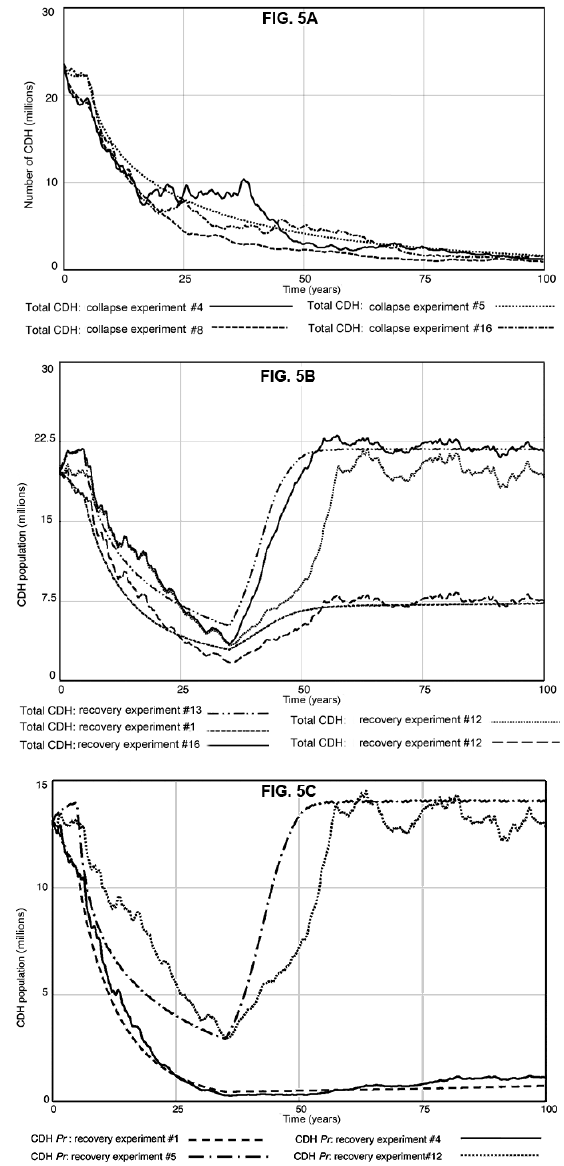
Fig. 5 . (A) Four examples of model runs showing the collapse trajectory of the total Callos de Hacha (CDH), or pen shell, population in different experiments. (B) Five example runs showing the collapse-and-recovery of the total CDH population in different experiments. Note that experiments #1 and #4 do not ever fully recover: this is because the Pinna rugosa ( Pr ) population has collapsed, as shown in Fig. 5C. (C) Four example runs showing the collapse-and-recovery of the Pr population in different experiments. The presence of either institutional Rule 3, the optimal foraging theory effort switching rule (experiment #5), or the institutional rule for limiting the harvesting of immature Pr (experiment #12) is sufficient to prevent collapse of Pr . CDH refers to Callos de Hacha, or pen shell, including either Atrina tuberculosa or Pr